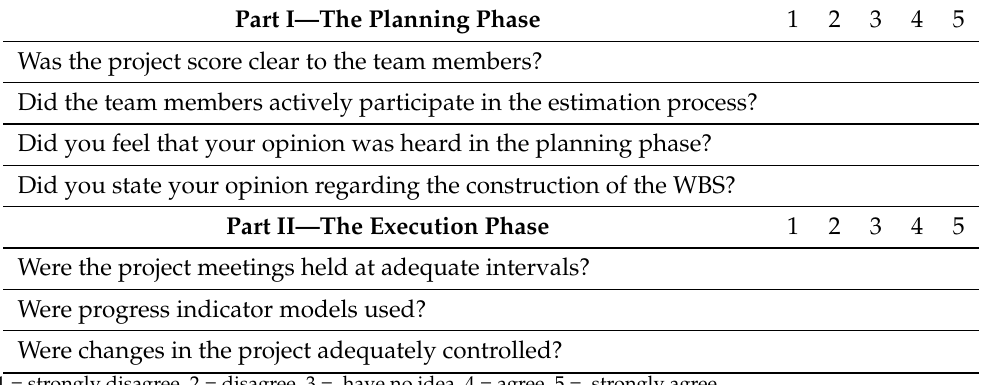
Table 1. Example of questionnaire with two questions.